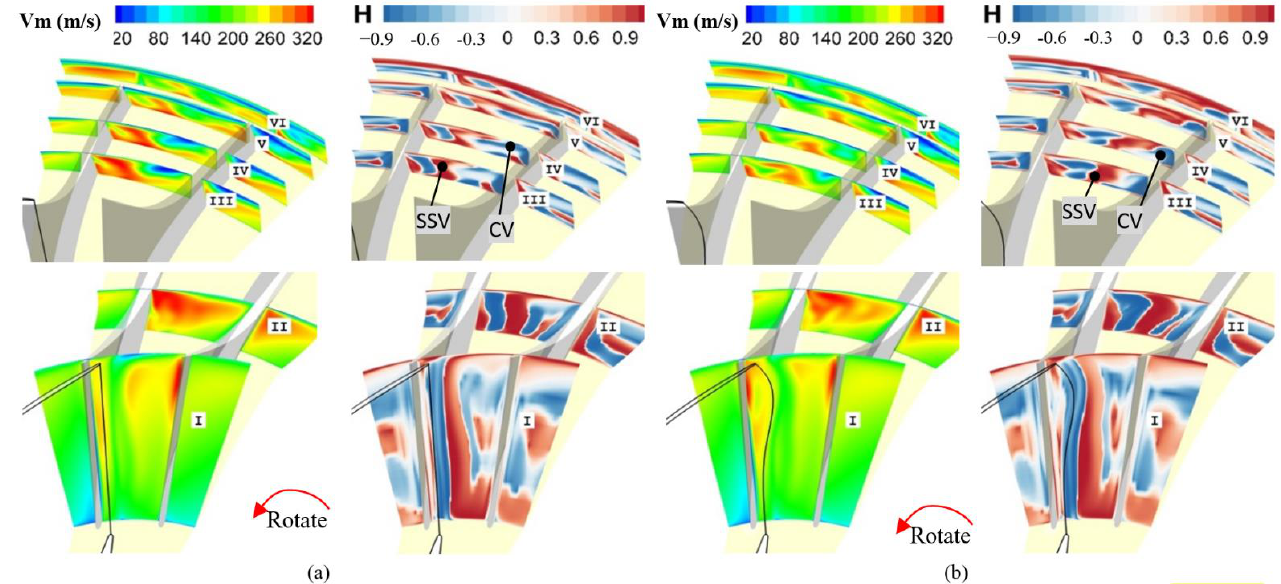
Energies 2022 , 15 , x FOR PEER REVIEW 29 of 32 Figure 25. Comparison of the loading distribution at a 95% span for different tandem impellers (P.E. point).